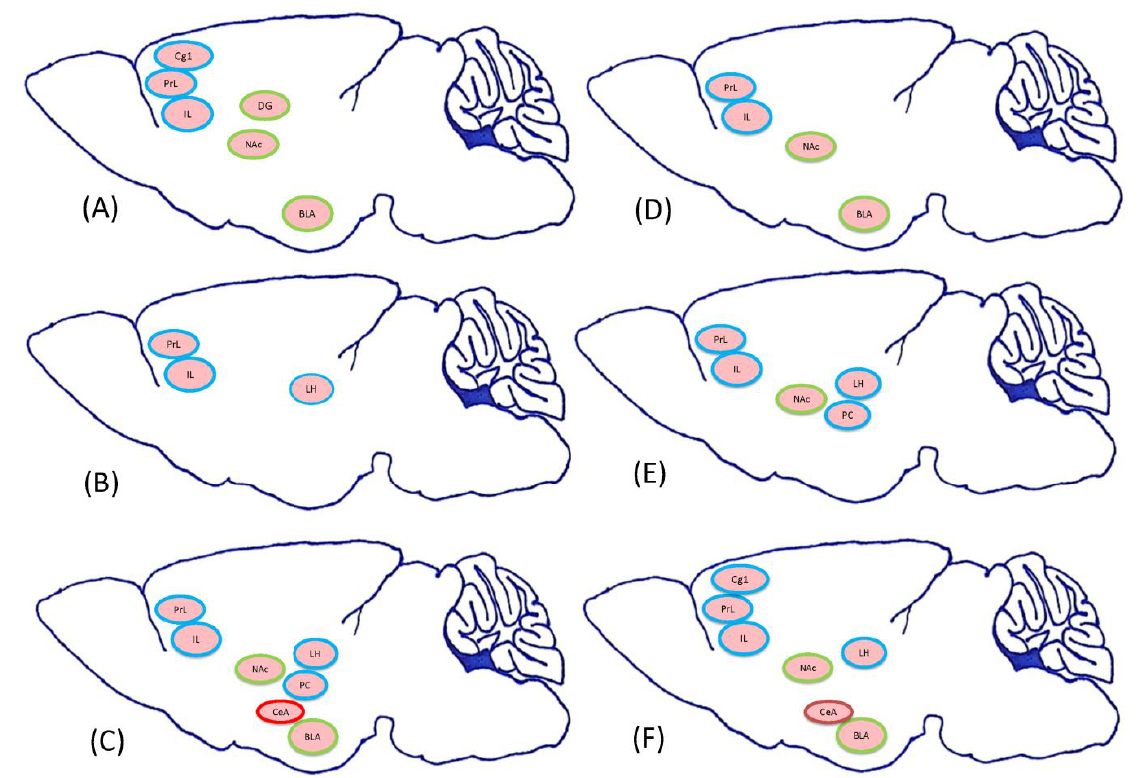
Figure 21. Representation of the neural substrates involved in morphine-induced conditioned suppression of saccharin solution intake for ( A ) conditioning, ( B ) extinction, ( C ) reinstatement to label c-Fos expression or for ( D ) conditioning, ( E ) extinction, and ( F ) reinstatement to label p-ERK. Based on the previous data, the rewarding, aversive, or both properties of neural substrates are, respectively, shown in blue, red, and green in outside circles. The inside filled red ovals represent the neural substrates involved in the aversive CTA effect in the present study. The examined neural substrates include the cingulate cortex area 1 (Cg1), the prelimbic cortex (PrL), the infralimbic cortex (IL), the nucleus accumbens (NAc), the CA1, the CA2, the CA3, the dentate gyrus (DG), the central amygdala (CeA), the basolateral amygdala (BLA), the lateral hypothalamus (LH), and the piriform cortex (PC).